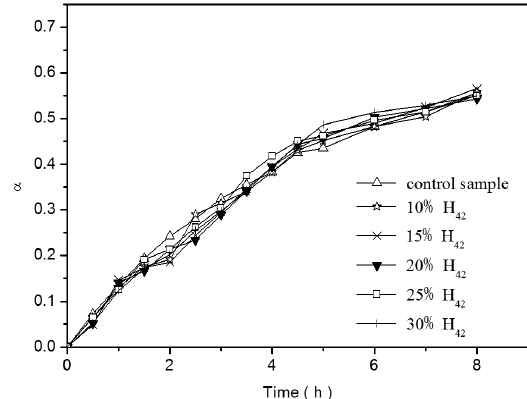
Figure 5. Conversion-time curves for the control sample and H-IPNs with different contents of H